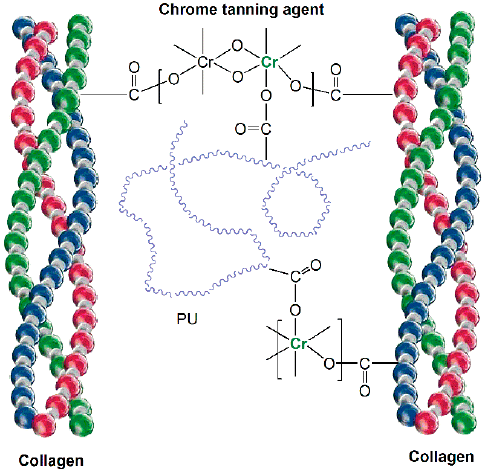
Figure 12. Mechanism of polyurethane retanning agent.